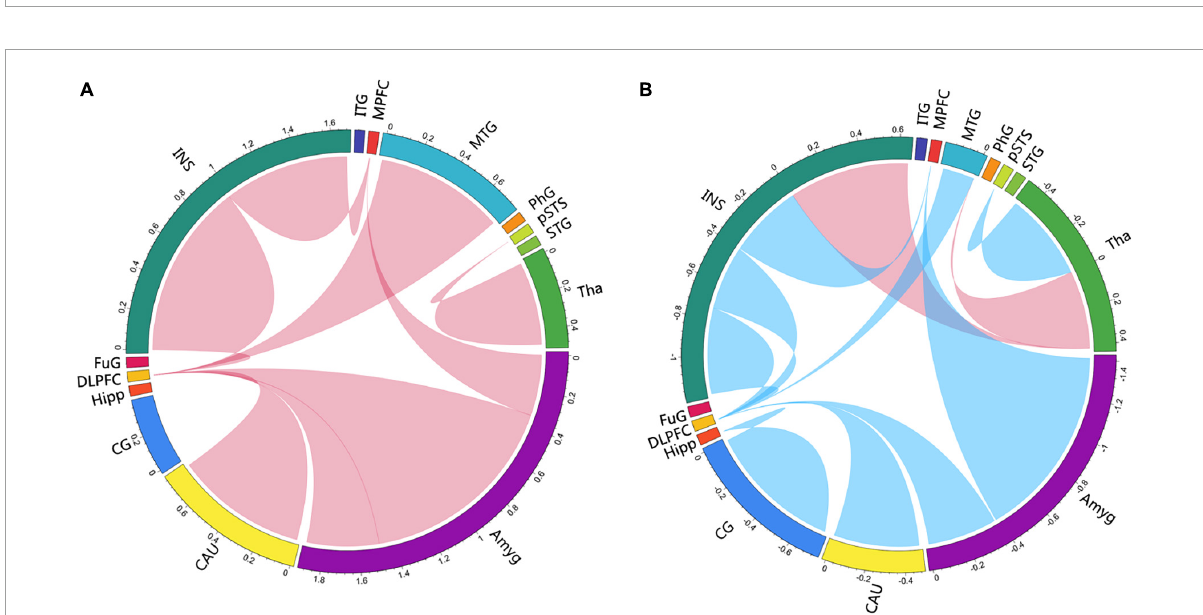
FIGURE5 Circlize maps of signed-path coefficient alteration after treatment in the immersive-VR group (A) and the control group (B) from multivariate granger causality analysis. The parameters represent the intensity of the signed-path coefficients differences after treatment as compared to baseline levels. Blue/red lines designate significantly weaken/strengthen of causal connectivity after treatment as compared to baseline levels. MPFC, medial prefrontal cortex; DLPFC, dorsolateral prefrontal cortex; MTG, middle temporal gyrus; pSTS, posterior superior temporal sulcus; INS, insular gyrus; CG, cingulate gyrus; Amyg, amygdala; Hipp, hippocampus; CAU, caudate, Tha, Thalamus.